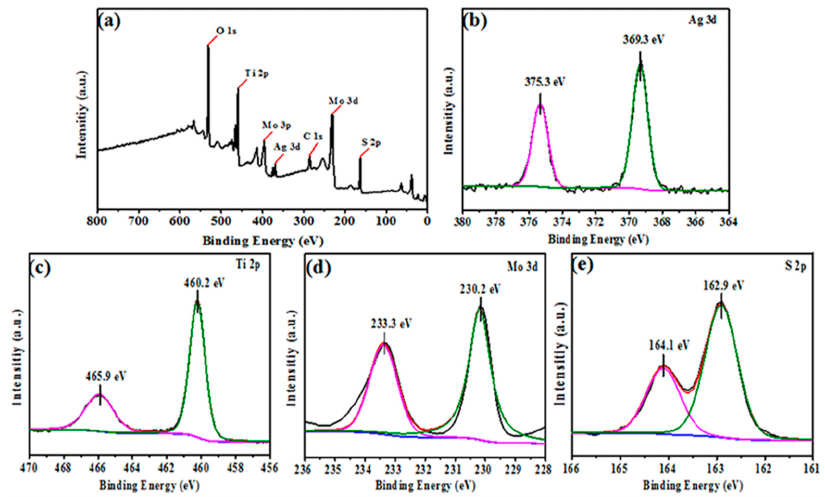
Figure 5. X-ray photoelectron spectroscopy (XPS) spectra of TiO 2 NTs/Ag/MoS 2 : ( a ) survey, ( b ) Ag 3d, ( c ) Ti 2p, ( d ) Mo 3d, and ( e ) S 2p.